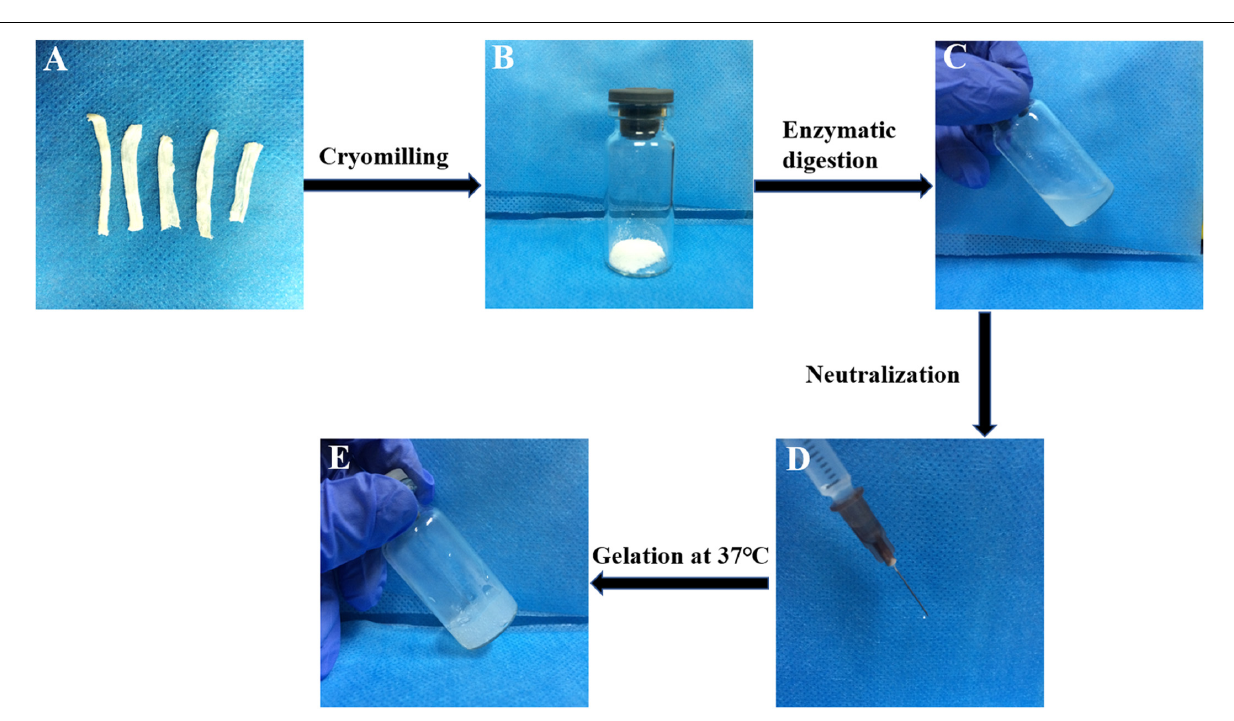
FIGURE 3 | A typical process for the production of the T-gel from decellularized tendon ECM. The DTSs (A) were cryomilled to form powder (B) , subjected to enzymatic digestion (C) , and then neutralized (D) after dissolution, and incubated at 37 ◦ C to form the T-gel (E)